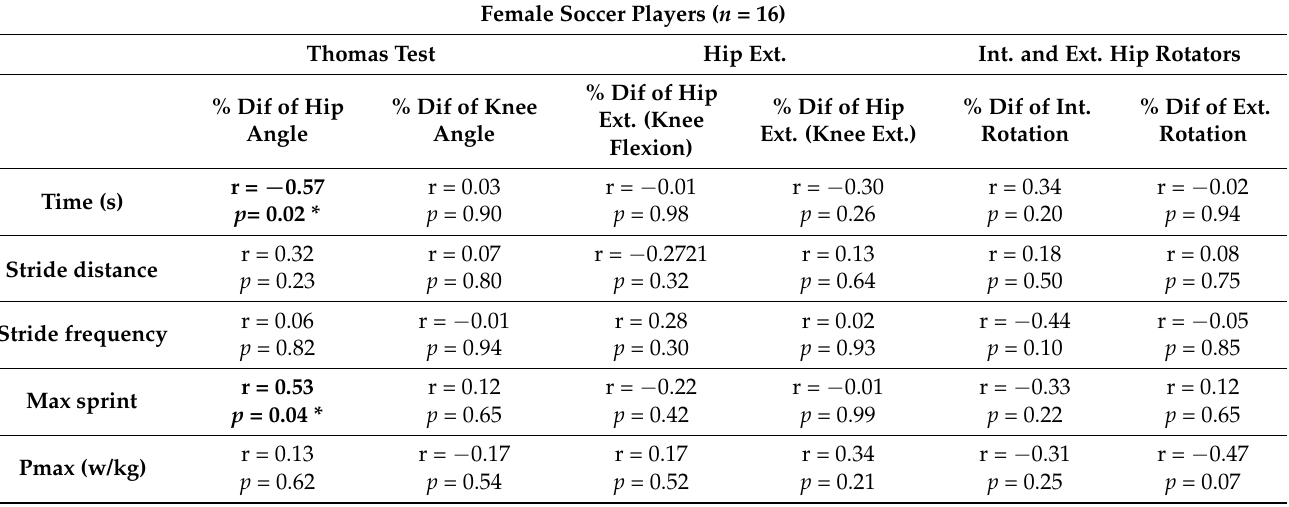
Table 3. Pearson’s correlation coefficient between linear sprinting and force–power–velocity values and % of difference in the Thomas test, hip extension, and internal and external hip rotators ( n = 16). Female Soccer Players ( n = 16) Thomas Test Hip Ext. Int. and Ext. Hip Rotators % Dif of Int. % Dif of Ext. Rotation